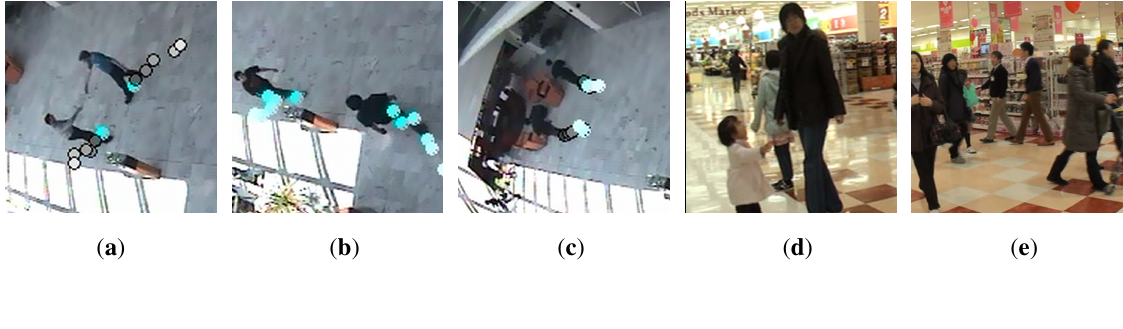
Figure 8. Pedestrians of same group are denoted with same marker and color, whereas pedestrians who do not belong to a group are denoted with gray